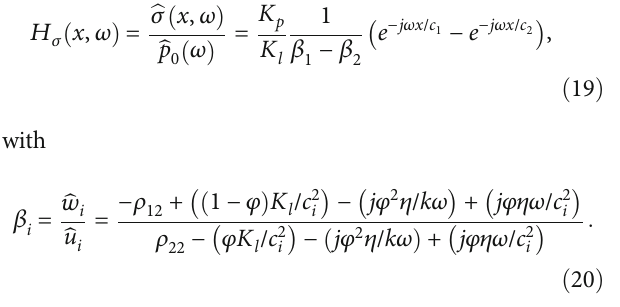
Figure 2: Phase velocity (a), damping factor (b), and phase di ff erence (c) of the fi rst wave versus normalized frequency ( Ω = ω / ω damping is the imaginary part of − ω / c i , i = 1, 2 . The phase velocity is the real part of the complex wave velocity. The red line denotes the Darcy-Brinkman law and the black line Darcy ’ s